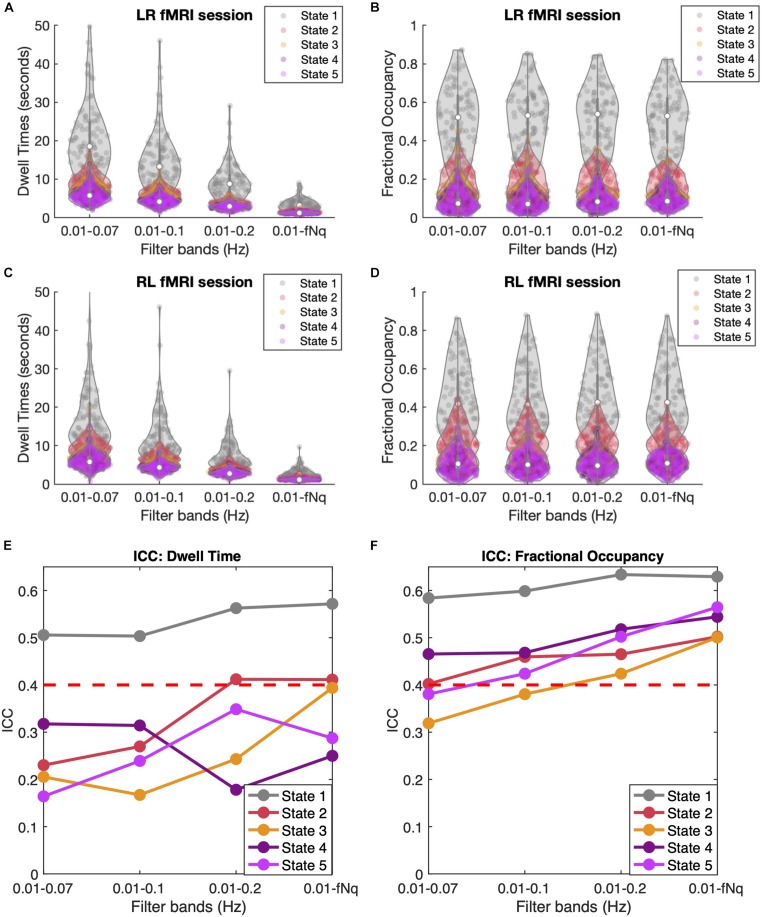
Temporal Filtering effect on Dwell Time and Fractional Occupancy. (A,C) Dwell Times obtained across four different band-pass filters applied to the BOLD signals, keeping the lower bound fixed at 0.01 Hz and varying the higher (lowpass) cutoff frequency between 0.07, 0.1, 0.2, and 0.6944 Hz, which corresponds to the Nyquist frequency fNq = 1/(2TR). Results are shown for LR (A) and RL (C) recording sessions. (B,D) Fractional Occupancies across the four different filtrations for LR (B) and RL (D) recording sessions. (E,F) Inter-Class Correlation (ICC) across four different filtrations for Dwell Times (E) and Fractional Occupancy (F). The red dashed line represents the threshold for moderate reliability based on the Landis and Koch (1977) ICC scale.